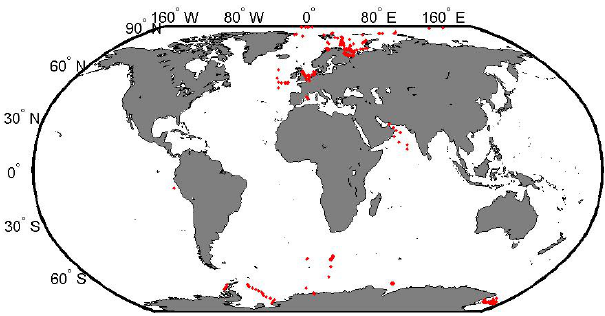
Figure 2. Global distribution of stations where Phaeocystis abun- dance counts were made available for this study. Most stations are located at temperate latitudes and in coastal areas. Figure 1. Flow diagram of methodology used to derive mean the expected mucus biomass per cell (Table 2). Phaeocystis biomass estimates from abundance data for single cells, Fig. 1. Flow diagram of methodology used to derive mean Phaeocystis biomass estimates from abun- Fig. 2. Global distribution of stations where Phaeocystis abundance counts were made available for this dance data for single cells, colonial cells and unidentified cells. Abundance data was converted to bio- colonial cells and unidentified cells. Abundance data was converted volume, and a biovolume to carbon ratio was applied to derive biomass. Finally, an estimate of mucus to biovolume, and a biovolume to carbon ratio was applied to de- study. Most stations are located at temperate latitudes and in coastal areas. carbon was added for colonial cell types. rive biomass. Finally, an estimate of mucus carbon was added for figure colonial cell types.